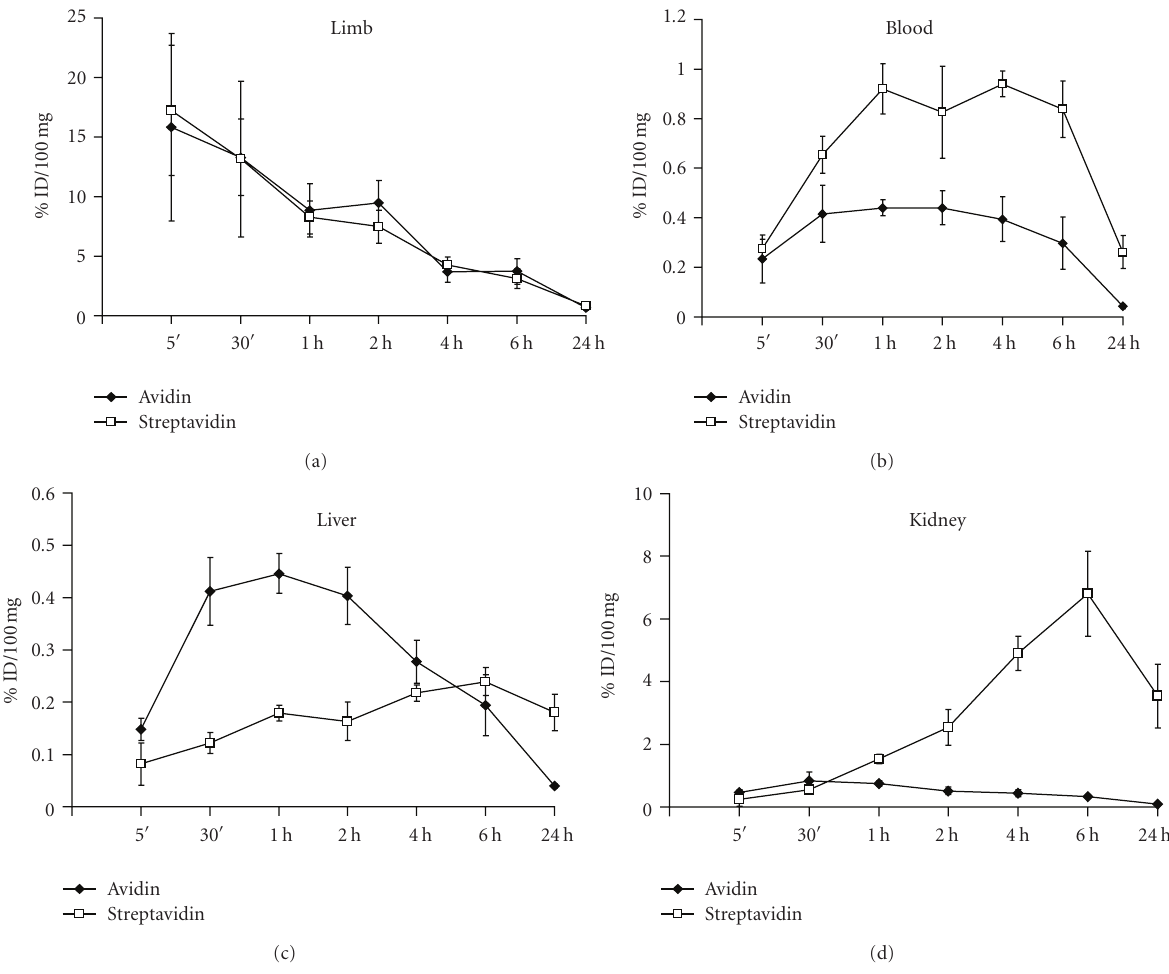
Figure 1: Di ff usion kinetic of 125 I-labeled avidin or streptavidin injected in a limb and distribution in blood, liver, and kidney. At indicated time points, mice were sacrificed and tissue samples weighted and counted in a gamma-counter. Data are expressed as % ID/100mg of tissue. Each point is the average of 5 mice. Bars represent standard